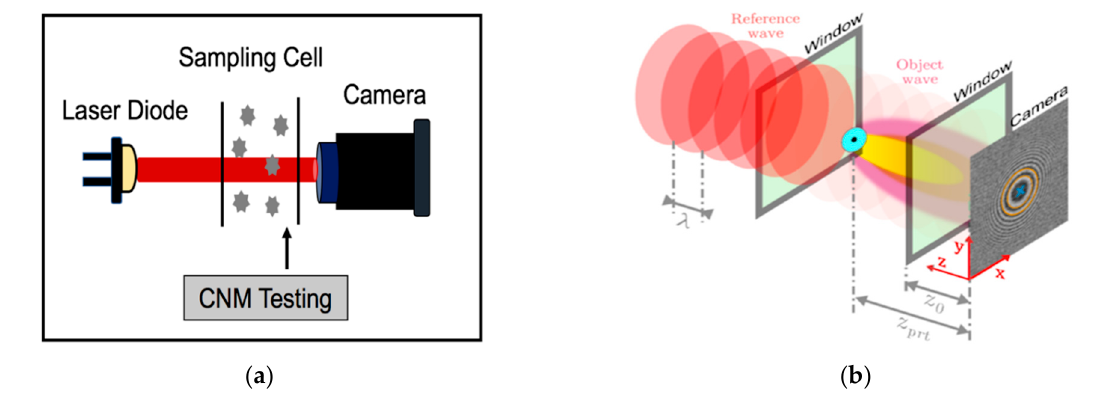
Figure 10. The layout of optical holographic particle counter; ( a ) holographic counting unit; ( b ) holographic principle and creation of a fringe pattern with a camera detection system.